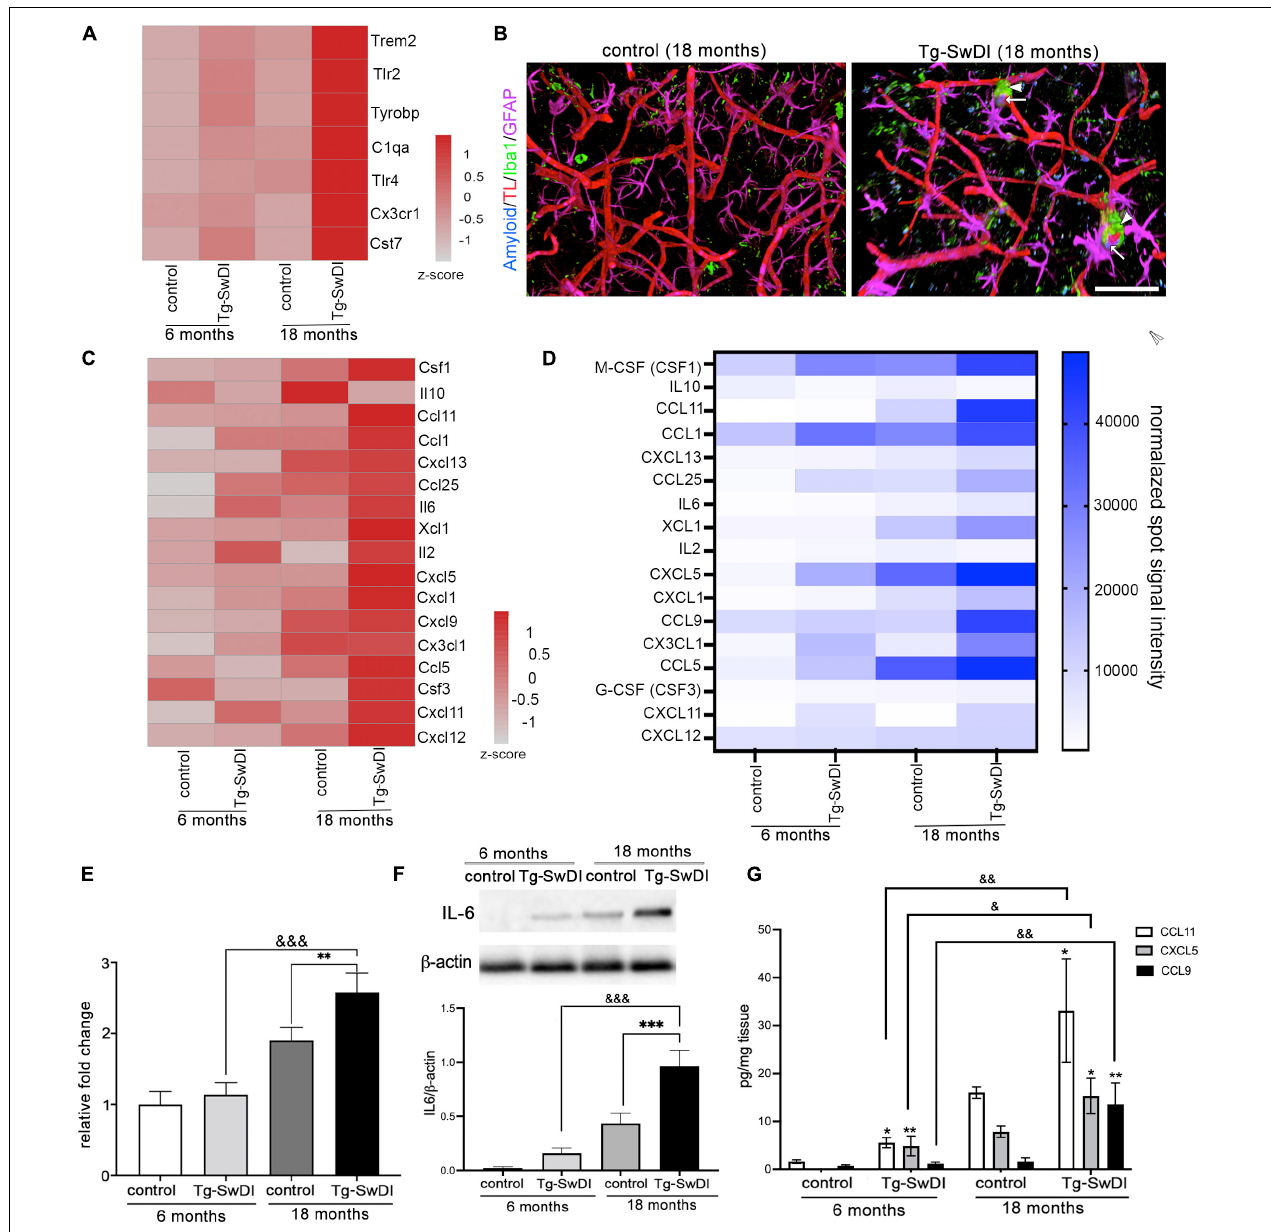
FIGURE 6 | The inflammatory profile of brain microvessels in CAA vasculopathy. (A) Heat map of differentially expressed genes related to microglial activation in microvessels in all experimental groups. The color scale represents the row z -scores of normalized gene counts. (B) Representative images of the maximum 3D projection of z-stack (400, 400, and 200 µ m) with immunofluorescence for astrocytes (GFAP, Far Red) and microglia (Iba1, green) in the cortex of Tg-SwDI (18 months) and corresponding control mice. Blood vessels were labeled with Tomato lectin (red) and A β with Amyloid Glo (blue). Scale bar = 100 µ m. (C) Heat map of the part of differentially expressed genes related to chemokine and cytokines in all experimental groups. The color scale represents the row z -scores of normalized gene counts. (D) Heat map of the inflammatory protein array from all experimental groups. The selected cytokines/chemokines verify the altered gene expression identified in RNA seq analysis. (E–G) Verification of alterations in mRNA and protein expression for select genes. (E) Real-time RT-PCR confirmed ICAM-A upregulation in Tg-SwDI mice as well as in old WT mice. Values are means ± SD, n = 3. ∗∗ p < 0.01 vs. corresponding aging control; &&& p < 0.001 vs. young Tg-SwDI. (F) Western blot and semi-quantitative densitometric analysis of IL-6 protein expression in microvessels isolated from young Tg-SwDI (6 months) and old Tg-SwDI (18 months) mice and corresponding age-matched controls. Protein levels were normalized to β -actin. Graph represents means ± SD, n = 3; ∗∗∗ p < 0.001 comparing Tg-SwDI to age matched control and &&& p < 0.001 comparing genotypes of different ages. Western blotting image is one of three independent experiments. (G) Chemokines CCL11, CCL9 and CXCL5 protein level in brain microvessels evaluated by ELISA in all experimental groups. Values are means ± SD, n = 3. * p < 0.05 and ** p < 0.01 vs. corresponding aging control; & p < 0.05 and && p < 0.01 vs. young Tg-SwDI.